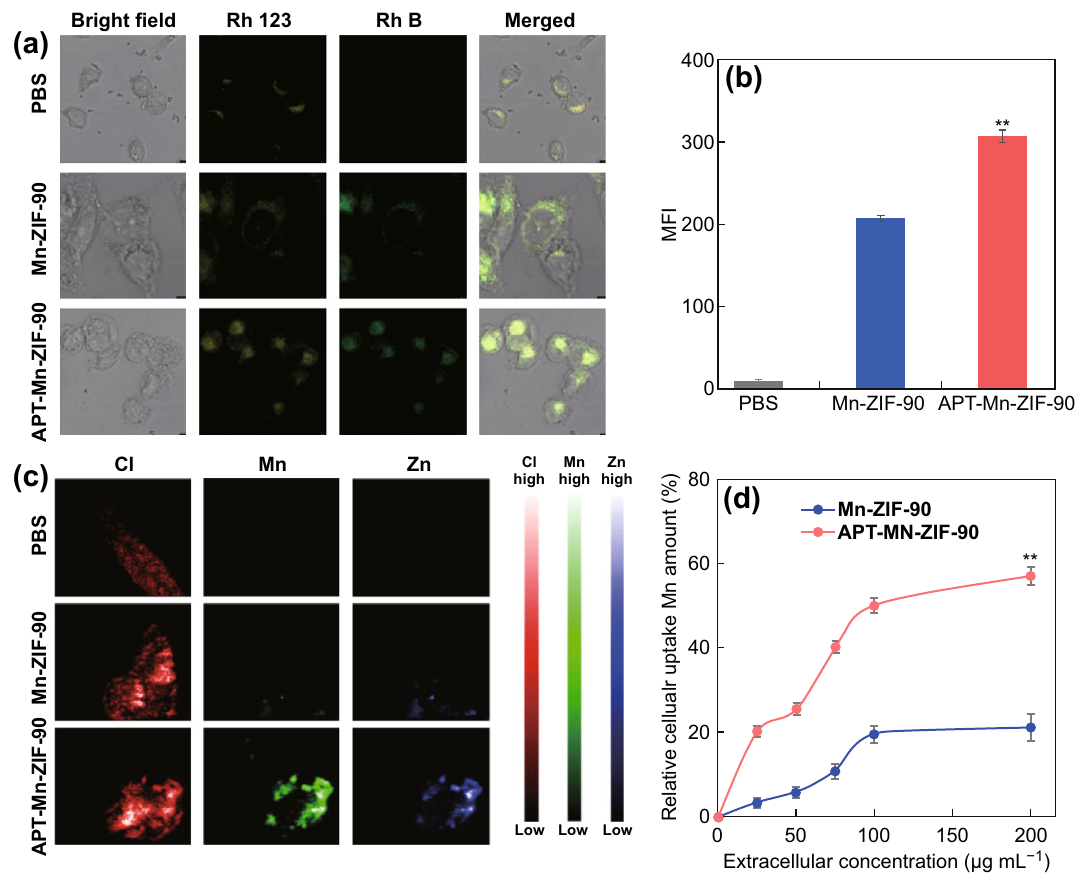
Fig. 2 Cellular uptake of NPs in MCF-7 cells. a LSCM images of RhB-loaded Mn-ZIF-90 and APT-Mn-ZIF-90 incubated with MCF-7 cells for 8 h, and the RhB 123 was used as a mitochondrion tracker; b mean fluorescence intensity (MFI) of MCF-7 cells incubated with NPs for 8 h, and followed by flow cytometric analysis; c XRFM images of Cl, Zn, and Mn in MCF-7 cells incubated with NPs for 8 h; d the concentration of Mn 2+ in MCF-7 cells after incubating with different concentrations of NPs for 24 h. Mean ± SD ( n = 3), ** p <